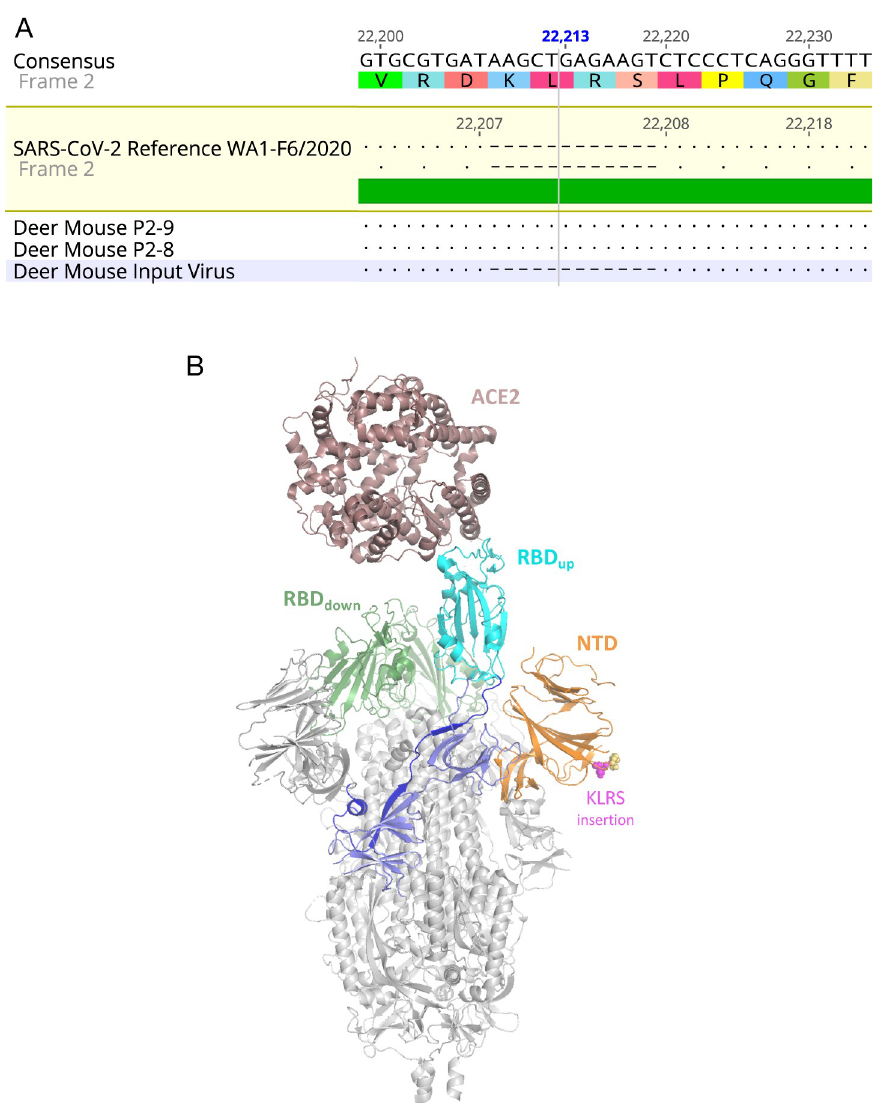
Fig 5. Spike protein insertion after serial passage in deer mice. (A) Passage of SARS-CoV-2 led to fixation of a 4-residue insertion in the N-terminal domain. Oral swabs of both DM8 and DM9 passage 2 deer mice (P2-8, P2-9, respectively) were submitted to RNA-Seq and an insertion was detected in all reads spanning residues 216–219 (nt 22,208–22,209, hatches) of the spike protein, implying a strong purifying selection for the insert during passage. (B) Homology model of the spike protein-human ACE2 complex showing the location of the KLRS insertion observed in the P2 virus. Model was generated by threading the deer mouse P2 spike protein sequence into the EM structure of the open-state SARS-CoV-2 spike protein (PDB: 6VYB) and colored as follows: Core (grey), N-terminal domain (NTD, orange) with KLRS insert as magenta spheres and native loop residues as yellow spheres, interdomain linker (blue), receptor binding domain (RBD, cyan for one up-conformation copy, green for two down-conformation copies), SD1/ SD2 domains (light blue). The structure of the human ACE2 receptor (brown) was then superposed on the up- confirmation RBD using the crystal structure of the RBD-ACE2 complex (PDB: 6VW1).